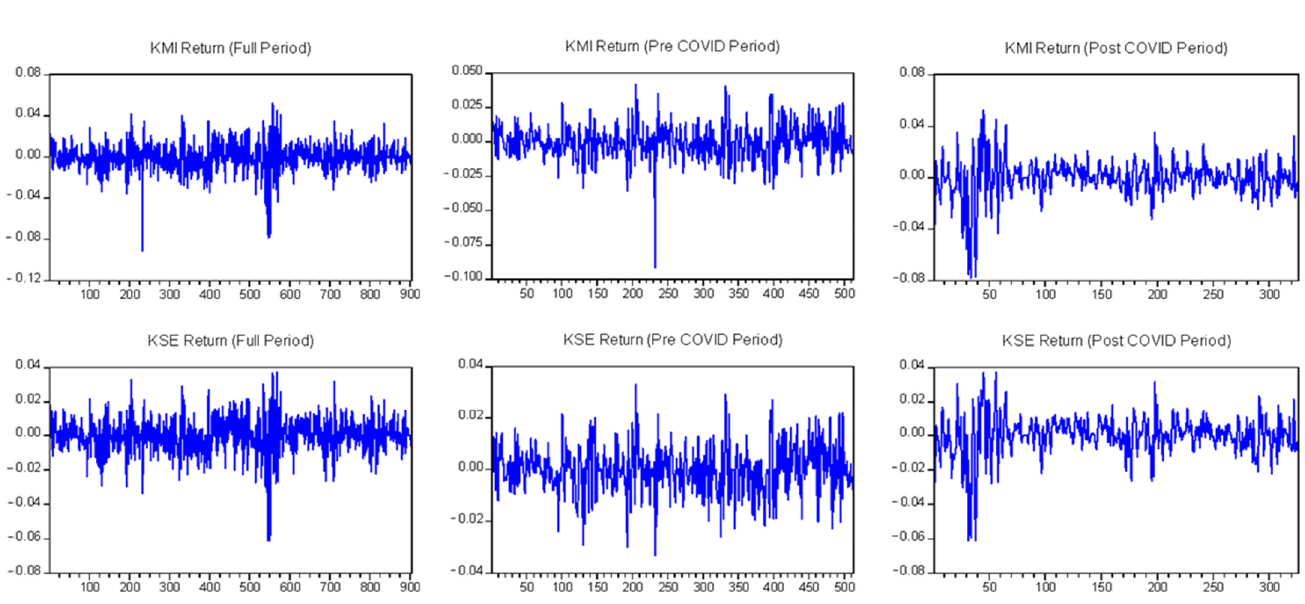
Figure 1. Volatility Clustering.